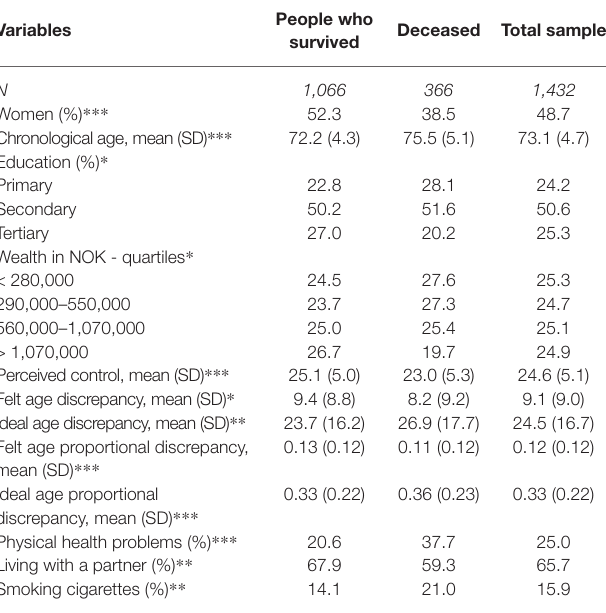
TABLE 1 | Baseline characteristics of the study sample according to survival status at the end of follow-up. Variables